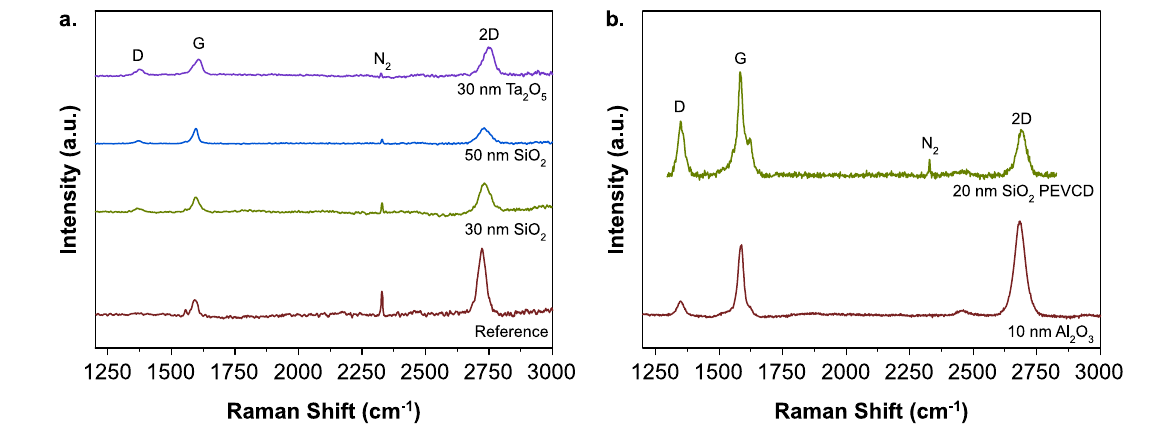
trum of transferred graphene grown on a Cu foil without further processing (Reference) is shown for comparison in ( a